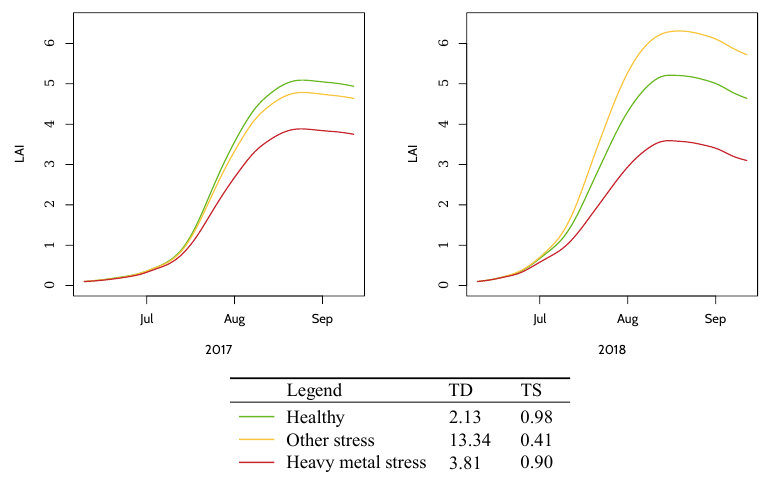
Figure 6. Temporal profiles of LAI series under healthy conditions, heavy metal stress and other stress